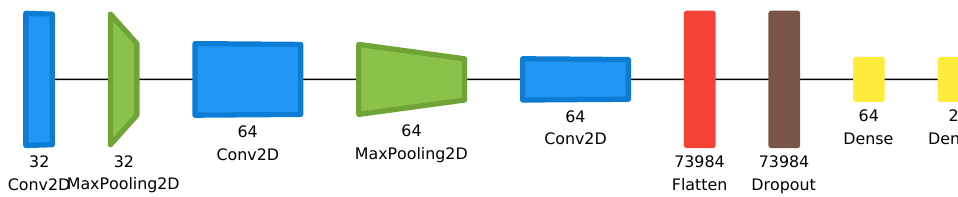
Figure 3. CNN architecture for fire detection